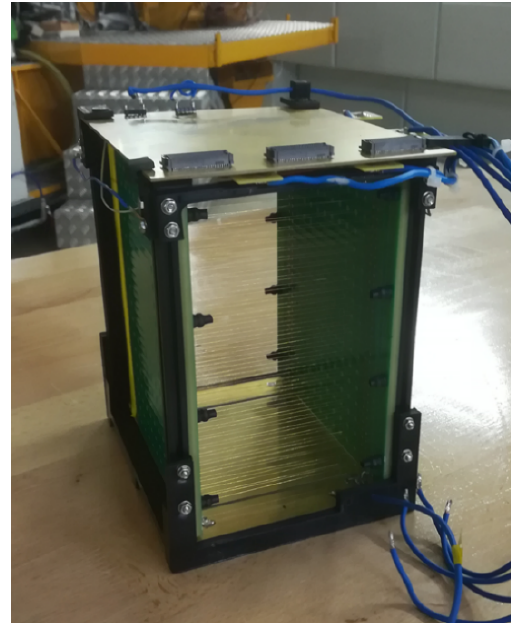
Fig. 4. View of the reduced-size tracker